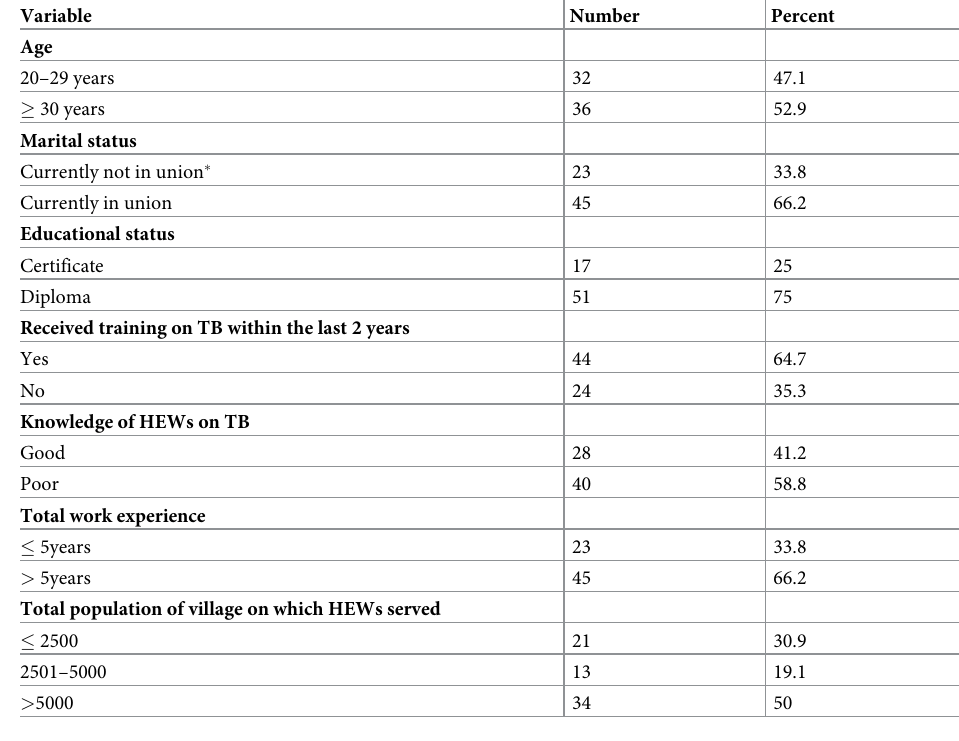
Table 1. Socio-demographic characteristics of the respondents, in Tigray region, Northern Ethiopia, 2018 (N = 68).